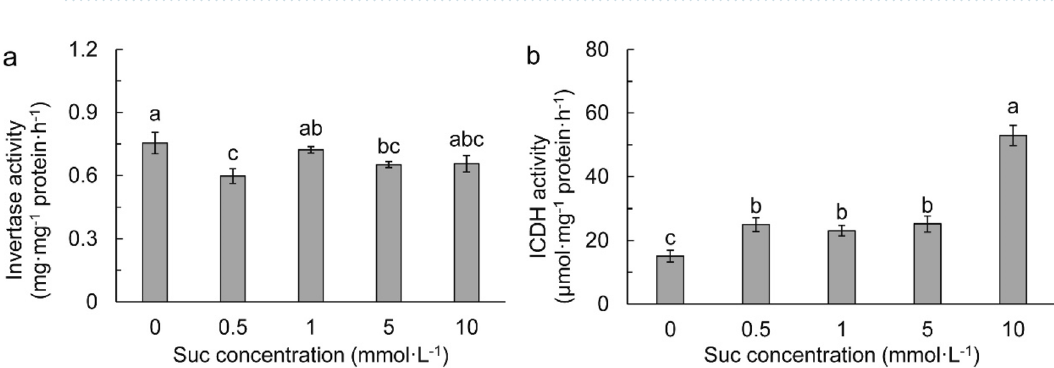
Figure 6. Invertase (IV, a ) and isocitrate dehydrogenase (ICDH, b ) activities in different sucrose concentrations. Data refers to means ± SE ( n = 4). Bars with the same letter are no statistically significantly difference at P < 0.05 by Duncan’s new multiple range